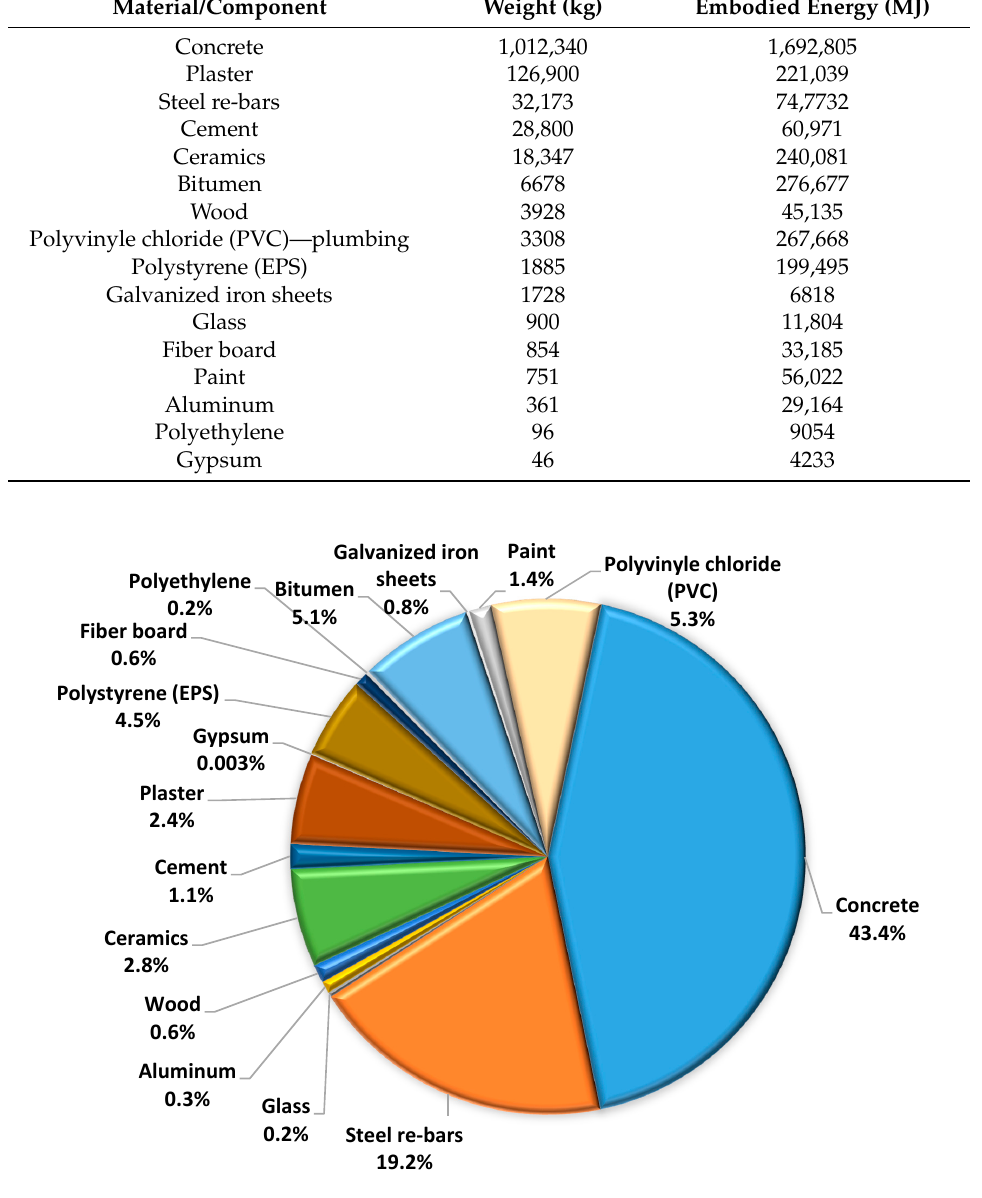
Figure 6. Distribution of the house embodied energy by the type of materials.